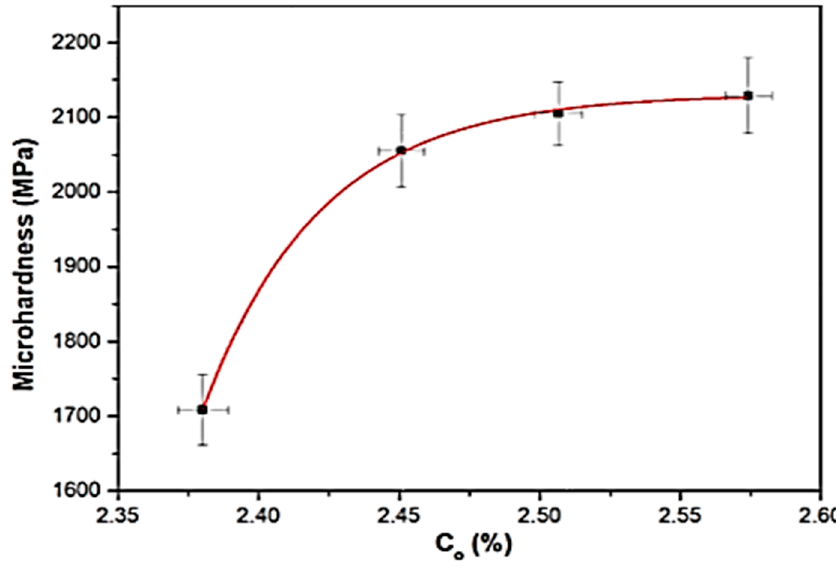
Figure 3. Microhardness vs. crystallographic orientation coefficient C o of NiTec coatings.